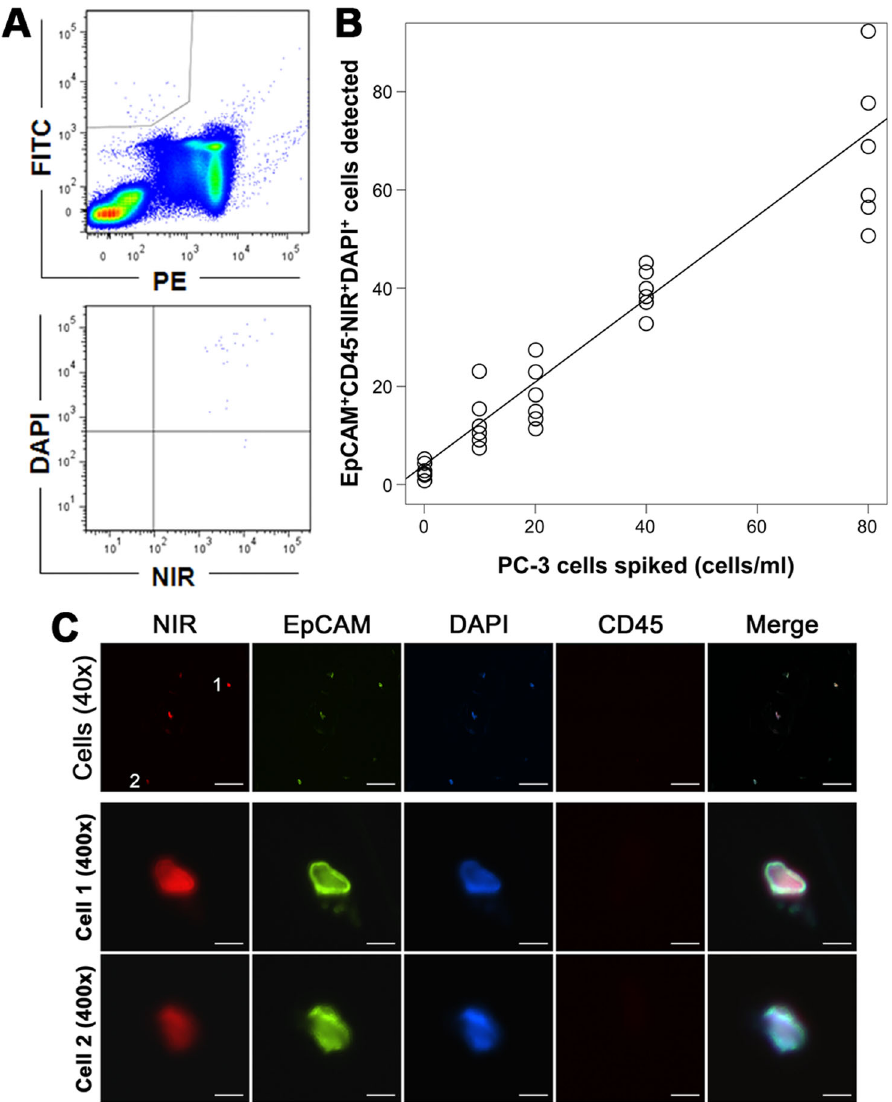
Figure 1. Calibrating the CTC detection method. Human PCa PC-3 cells were used as positive control cells. A , PC-3 cells stained sequentially with all four detection agents were subjected to FACS analysis. Upper panel: the sample was first detected for positive EpCaM (FITC) but negative CD45 (PE) stain (gated fraction). Lower panel: the gated fraction was queried for IR-783 (NIR) and nuclear (DAPI) stain. NIR + EpCAM + DAPI + CD45 2 counts were considered as live cancer cells. PC-3 detection was used in parallel in the analysis of each clinical specimen as guidance in gate setting. B , Efficiency of the detection strategy was assessed by comparing the number of spiked and detected PC-3 cells by FACS analysis. Each data point was the mean of detected PC-3 cells spiked to 6 healthy donor samples. C , Fluorescence microscopy was used to visualize PC-3 cells recovered onto a glass slide. Upper row shows the images of a representative field at low magnification (40 6 ; bar=250 m m), with two cells (marked with 1 and 2) presented at high magnification in the lower two rows (400 6 ; bar=25 m m). Gleason score, or margin status (Figure S3). Comparing CTC counts to the Stephenson predictive monogram, there was no statistically significant relationship between live CTC counts and the Stephenson predictive monogram.